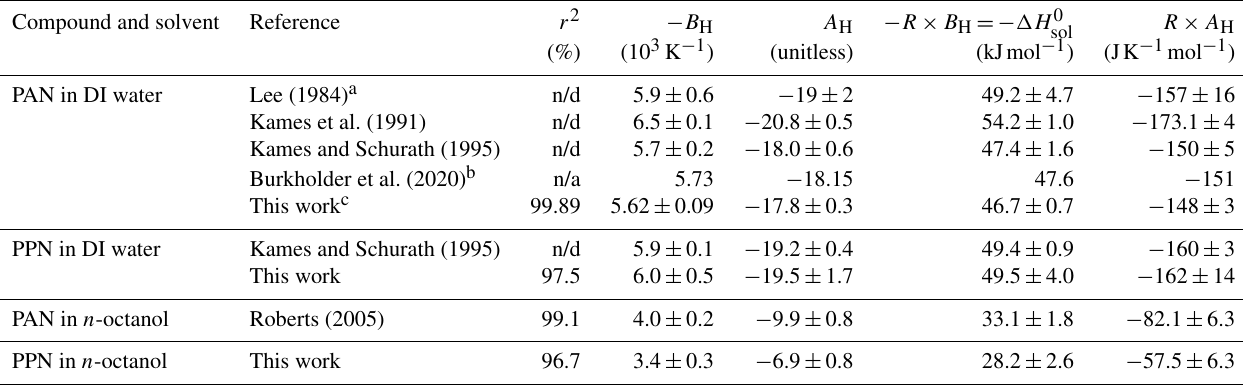
Table 2. Temperature dependence of Henry’s law solubility constants derived by linear fitting of Eq. (3) with C H = 0 to the data shown in Fig. 5. Compound and